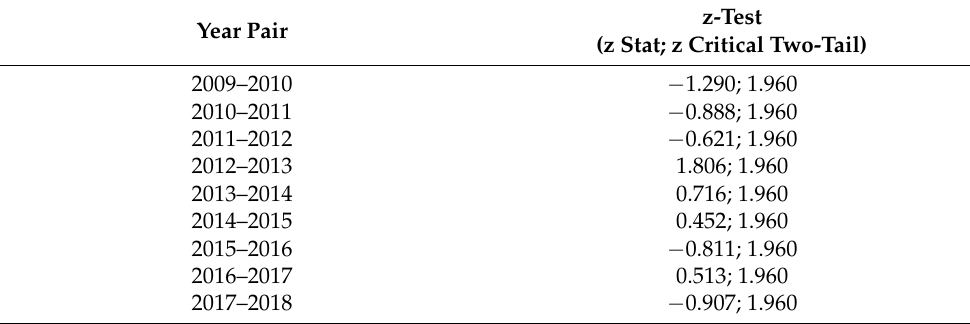
Table 4. Summary of the Welch’s t-test and the Chi-square statistic.